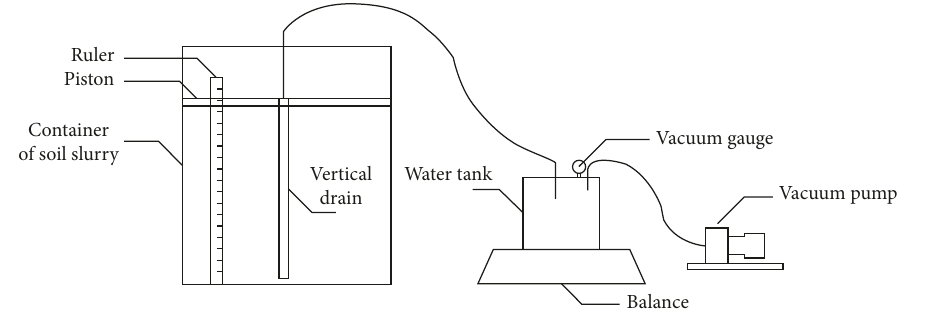
Figure 5: Schematic of the vacuum preloading test model.